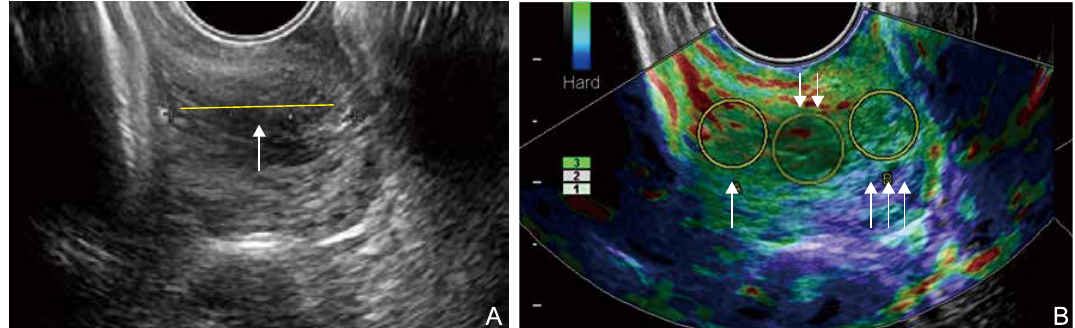
Figure 1 (A) The measurement of cervical length (↑): The vertical distance between the closed internal cervical os and the external cervical os. (B) Strain of cervix in three regions of interest: Closed internal cervical os strain rate (CIS) (↑), external cervical os strain rate (ES) (↑↑↑) and midpoint of the cervical canal strain rate (CCS)